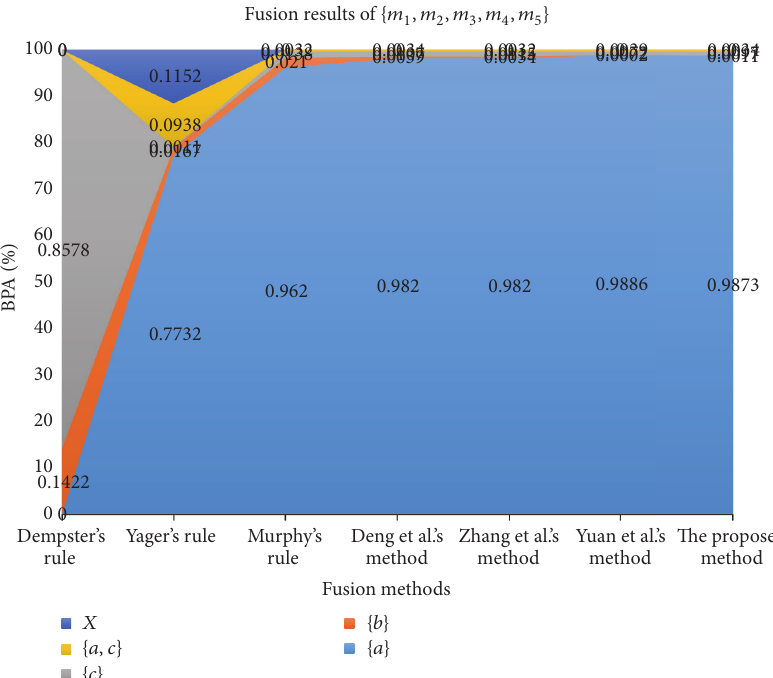
Figure 5: Fusion results of four BOEs.